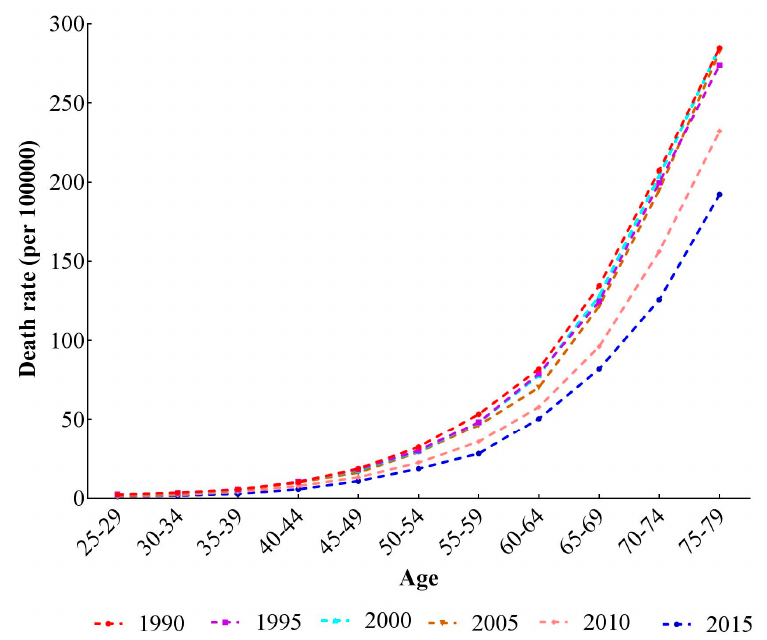
Figure 2. Age-specific stroke mortality-PM 2.5 in China from 1990–2015.